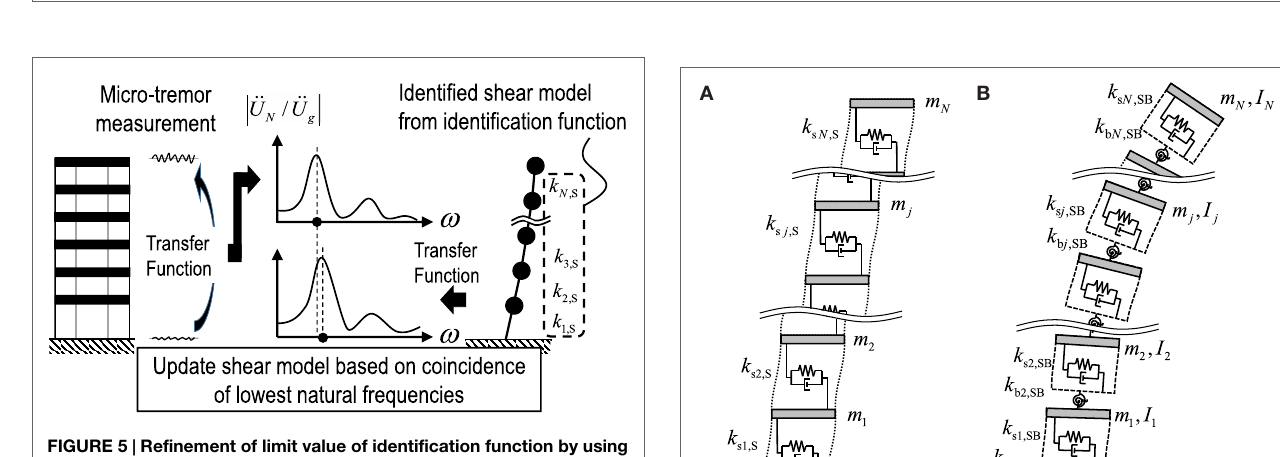
optimization procedure where the objective function is defined as an error of the fundamental natural frequencies between observed one and identified one. Figure 5 illustrates the concept of update of the IDF using the S